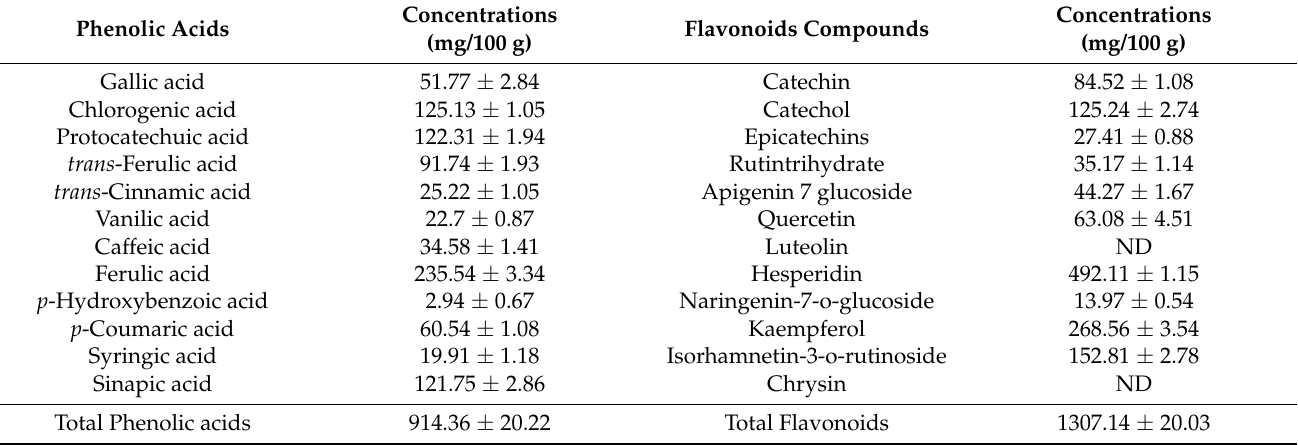
Table 2. Chemical constituents of phenolic compound contents of mandarin byproduct extract.